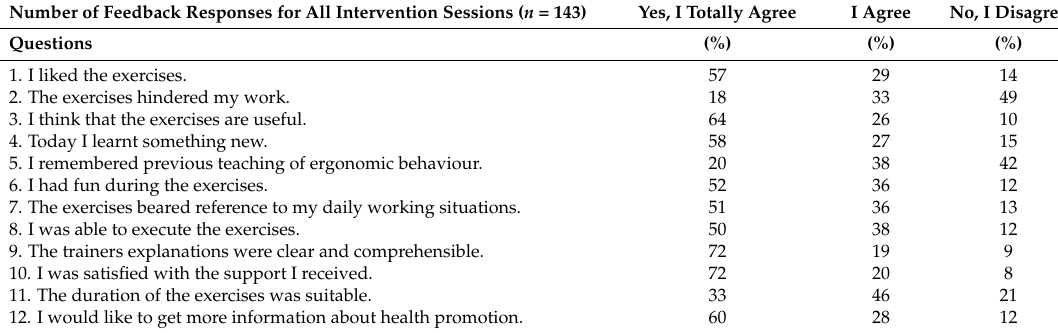
Table 3. Satisfaction with the intervention Application field 2 ( n =